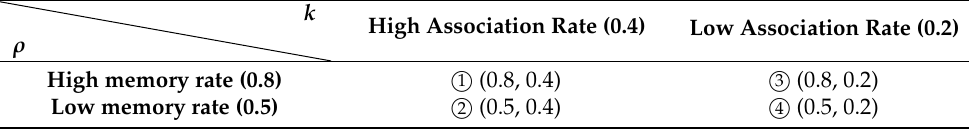
Table 12. Combinations of the different memory abilities. k High Association Rate (0.4) Low Association Rate (0.2) ρ High memory rate